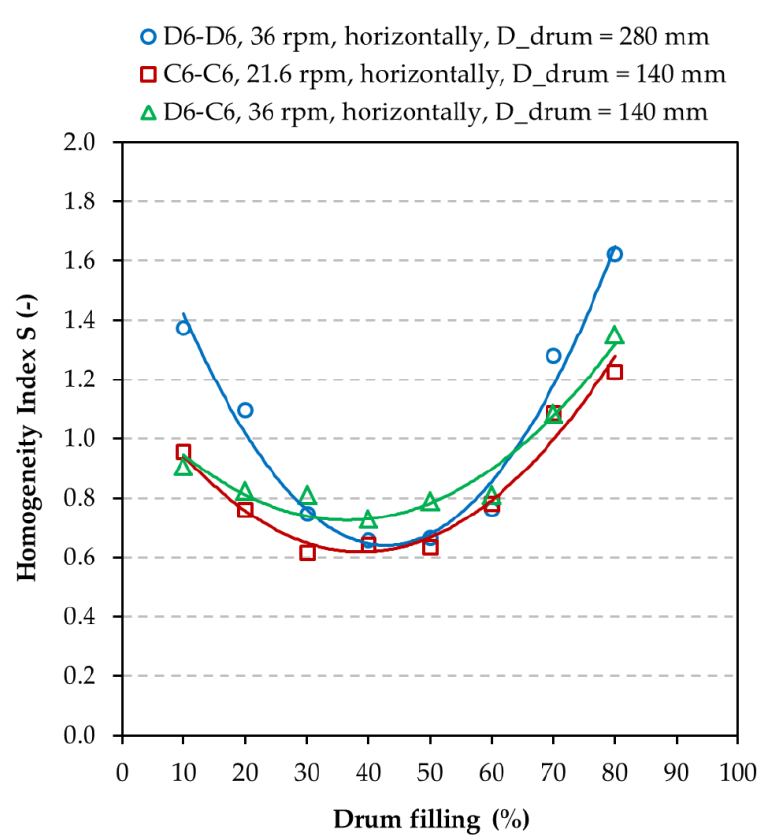
Figure 17. Influence of the degree of drum filling to the resulting homogeneity index of the mixture.